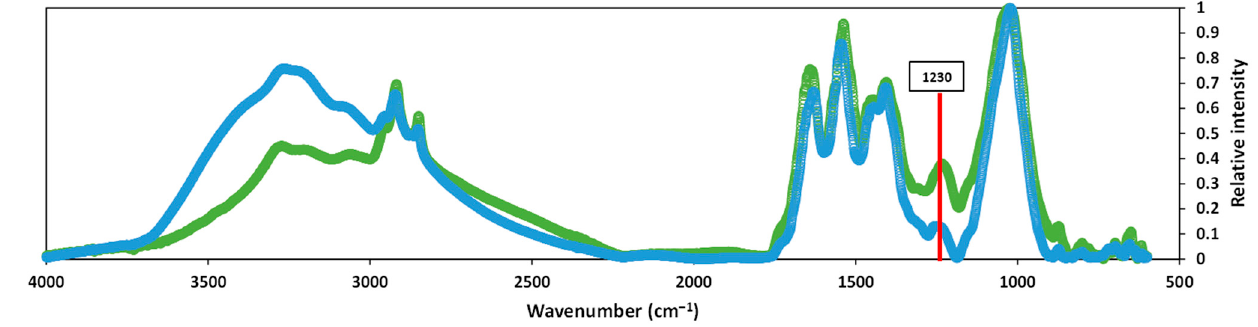
Figure 3. FTIR spectra of the feed (green lines) and effluent of CAD digester (blue lines).